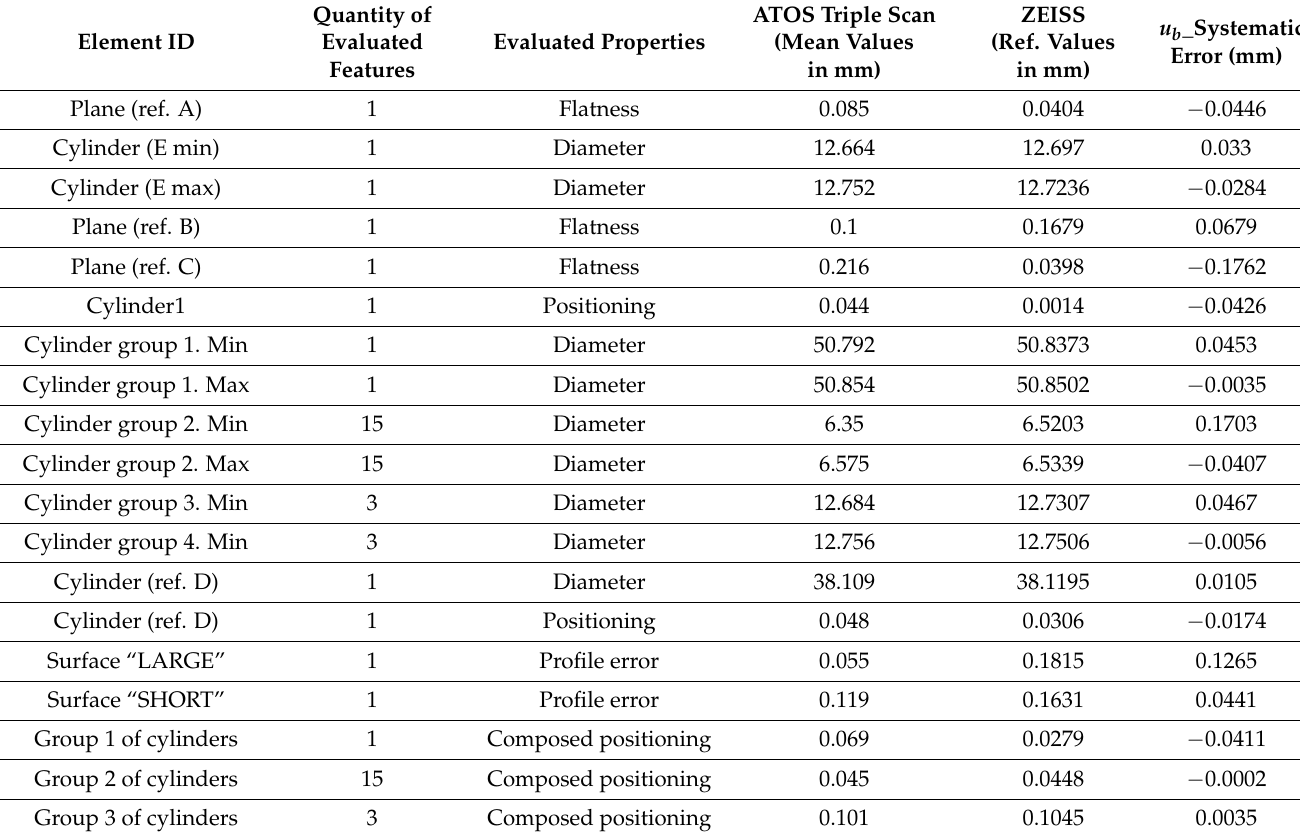
Table 3. ( u b ) uncertainty contributor according to ISO 15530-3 technical